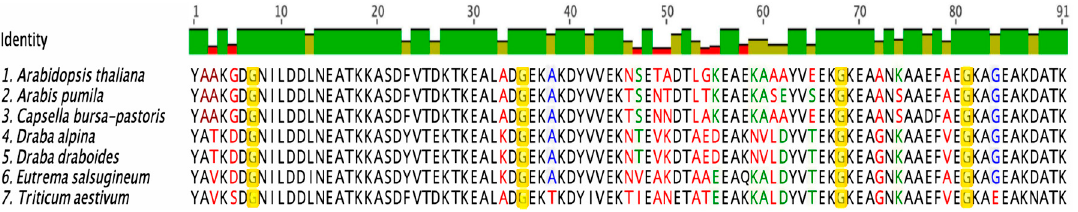
Figure 1. Sequence alignment of cold-regulated (COR) 15A homologs in various plant species. To examine the structure of the Arabidopsis thaliana COR15A sequence, alignments were performed using sequences of various species of plants that express this protein. The black letters indicate 100% sequence similarity, the blue letters indicate 80–99%, the green letters indicate 60–79%, and the red letters indicate less than 60% similarity. The residues highlighted in yellow are the glycine residues that are conserved in the examined homologs.